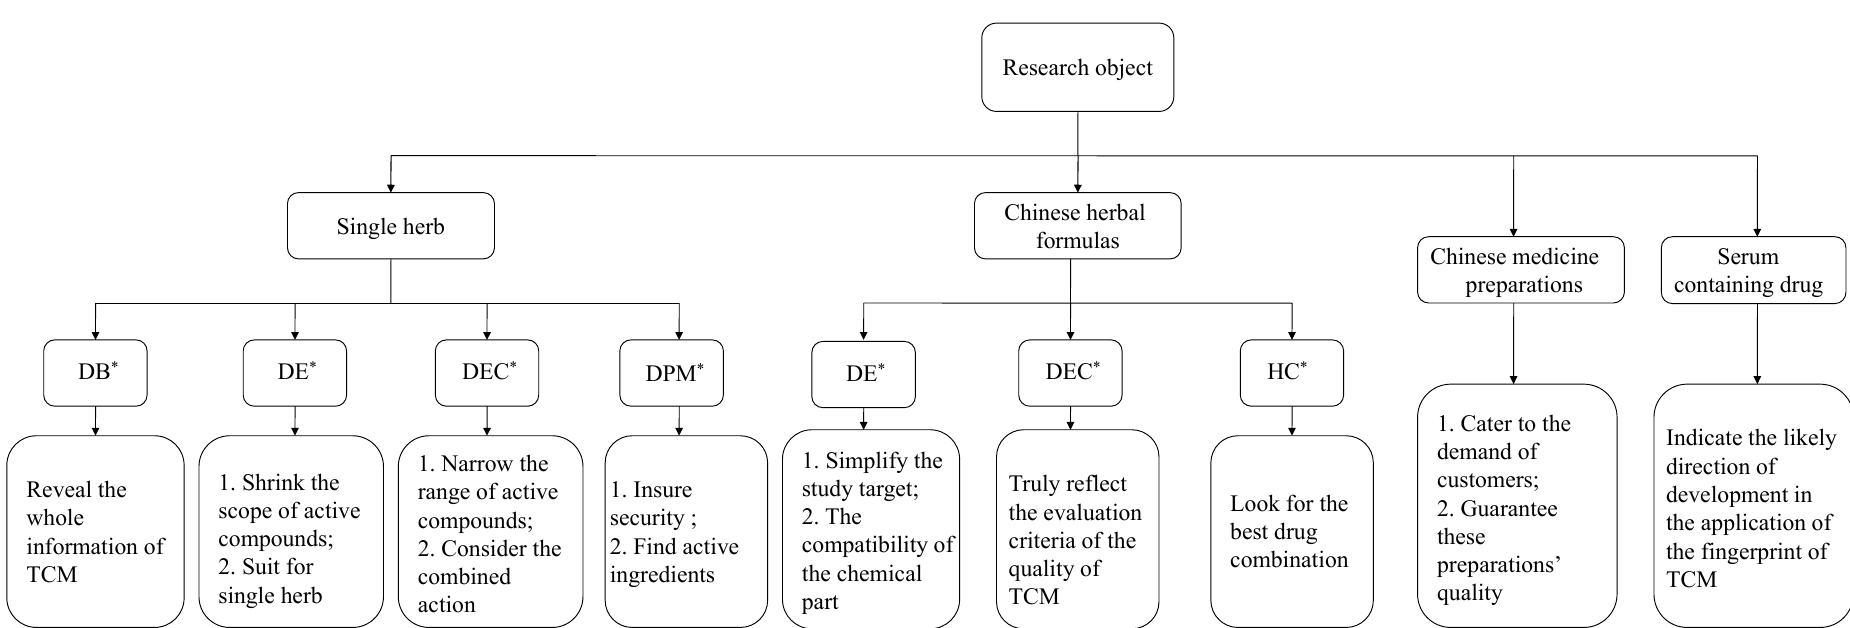
Figure 3. The spectrum-effect relationship research